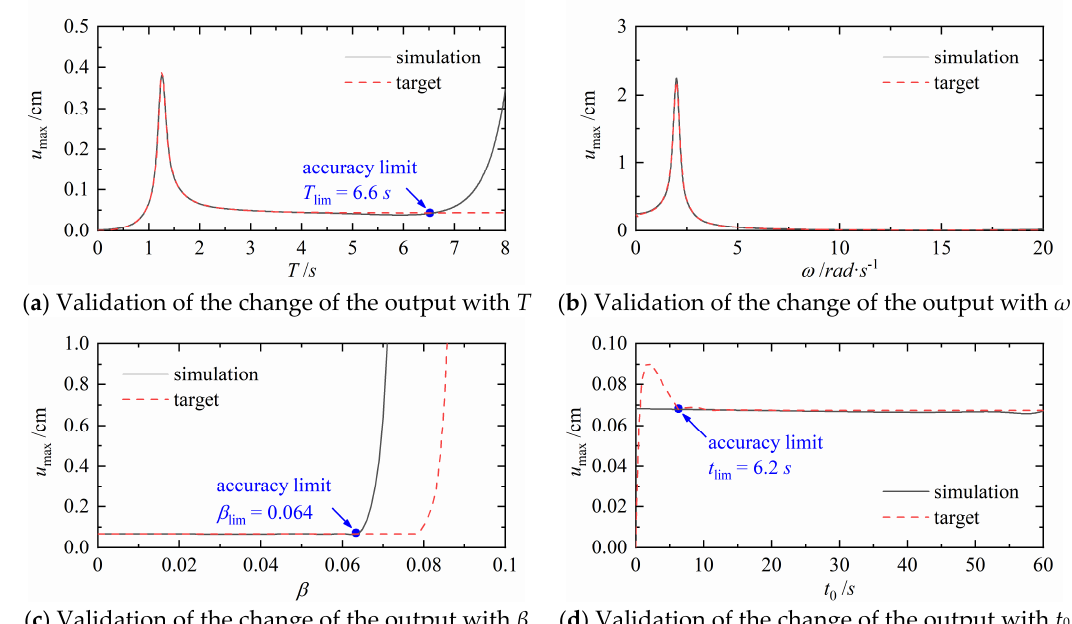
Figure 8. Validation of artificial neural networks with single changing parameter.